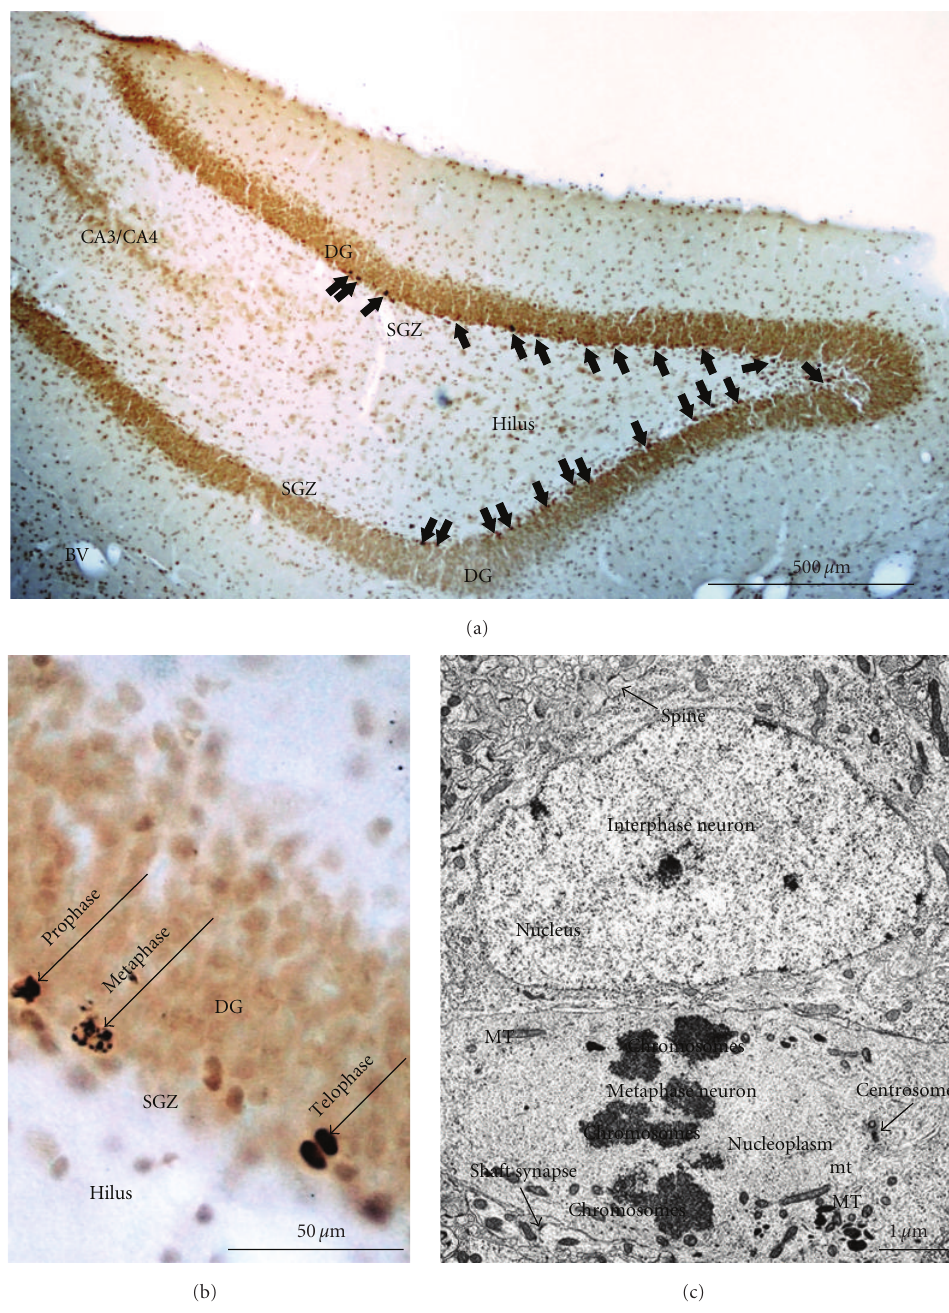
Figure 2: Light and electron microscopic patterns of dividing immature cells in the DG of hibernating animals. Mitotic phases are seldom found in normothermic animals (not shown here). (a and b) are light microscopic analysis of BrdU-immunoperoxidase-positive cells (arrowheads) in the DG of hibernating ground squirrel after injection of BrdU in interbout animal (on 50 μ m thick coronal slices). Note the distribution of BrdU-labelled cells in the SGZ. (b) Higher magnification light micrograph demonstrating granule cells where low temperature has halted division showing clearly di ff erent mitotic phases: metaphase and telophase due to hypothermia causing entrance into the hibernation state. (c) Ultrastructural details from an electron micrograph (6000 × magnification) of an early metaphase immature granule cell from rat hippocampus, (image adapted from a figure shown in Popov et al. [3]), with an interphase neuron located above the metaphase cell. Both immature interphase and metaphase granule neurons have synapses (interphase neuron-dendritic spine and metaphase one-shaft synapse) which are absent in mature granule cells of hippocampus of either ground squirrel or rat. BV: blood vessel; DG: dentate gyrus; SGZ: subgranular zone; mt: microtubules; and MT: